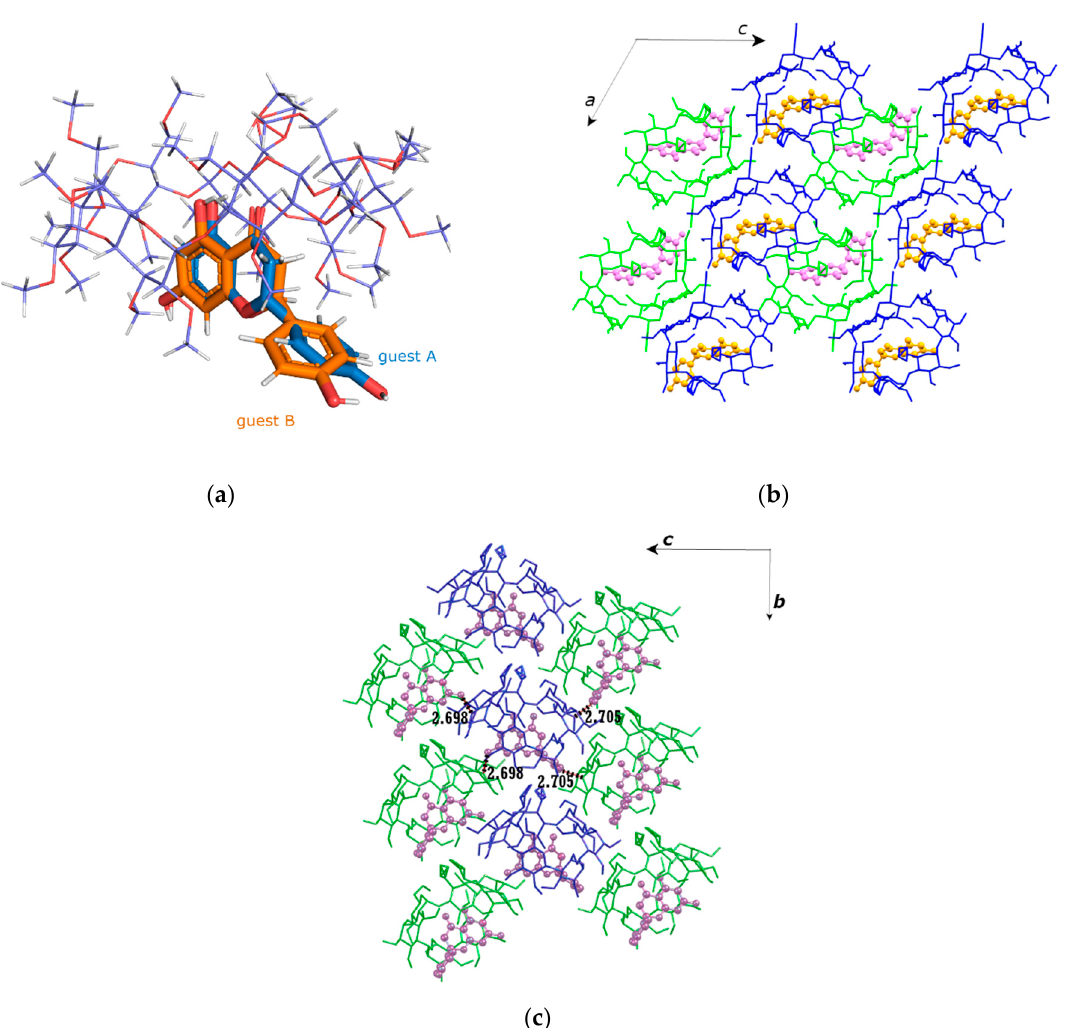
Figure 3. ( a ) The asymmetric unit of the naringenin/TM- β -CD inclusion complex; ( b ) projection onto the ac plane. The complex units of the columns deployed along the a -axis have opposite inclinations to the complex units of the columns deployed along the c -axis; and ( c ) projection onto the bc plane. Each complex unit is tightly packed in a cage-type mode with its open wide rim blocked by the primary and secondary methoxy groups of the adjacent complex units. Hydrogen bond distances (Å) between guest and host molecules of adjacent complex units are denoted.